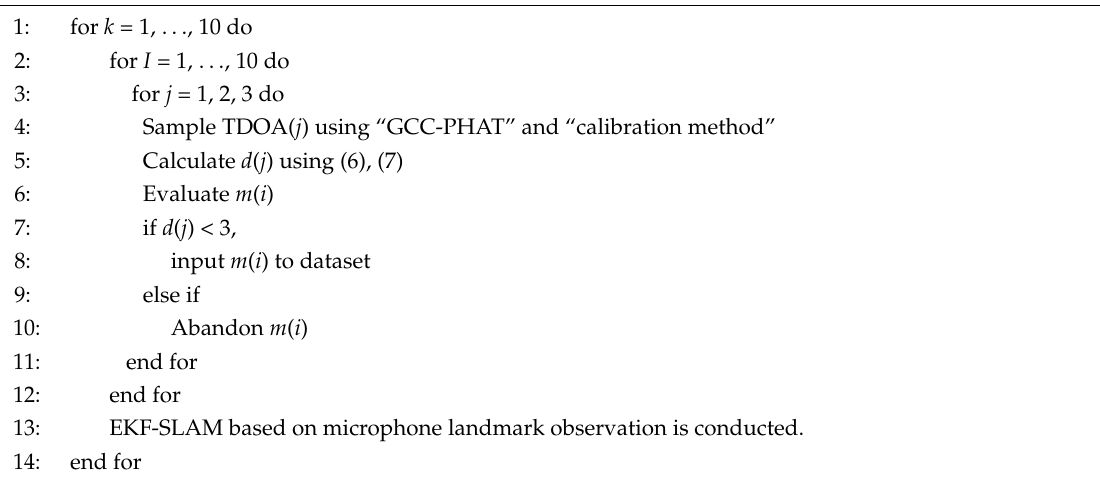
Table 3. Algorithm of acoustic EKF-SLAM based on microphone landmark observations. Algorithm 1: Algorithm of Acoustic EKF-SLAM Based on Microphone Landmark Observation